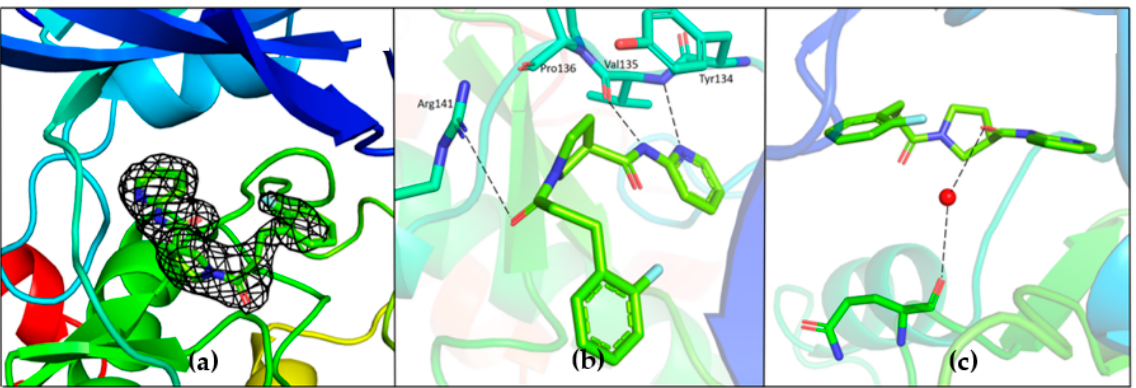
Figure 8. ( a ) Electron density corresponding to G12 contoured at 1.2 Sigma; ( b ) Hydrogen bonding interaction of G12 with the residues of hinge region; ( c ) Water-mediated hydrogen bond between carboxamide oxygen of G12 and Gln185; PDB 7U2Z.